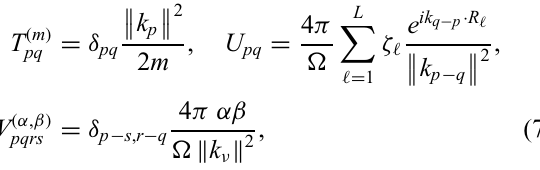
TABLE I. Best quantum algorithms for phase estimating chemistry in a plane-wave basis. N is number of basis functions, η < N is the number of electrons, (cid:10) is the computational cell volume, and (cid:9) is target precision. In some of these papers it is assumed that (cid:10) ∝ N or that (cid:10) ∝ η , but here we report the complexities without any such assumptions. Unlike other entries here, the scaling of the Kivlichan et al. [24] algorithm is empirically observed for specific systems (with some systems scaling somewhat better and some systems scaling somewhat worse) as opposed to rigorous upper bounds. The O ( N log N ) space complexity of Refs. [5,11,28] results from a Fourier-transform-based method of computing the potential operator discussed in Ref. [5]. If those papers were instead to use the Trotter steps introduced in Ref. [23] or Ref. [24], the algorithms would have N + O ( log N ) space complexity but gate complexity that is worse by approximately a factor of N . Algorithms with O ( N ) space complexity are likely impractical for any real problems in chemistry when using plane waves due to the large number of plane waves required to reach chemical accuracy; thus, O ( N log N ) space complexity is even less viable. We note that Appendix K introduces new algorithms defined in real space that match the scaling of those from Babbush et al. [42]. Primary innovation Logical qubits Toffoli/T complexity (cid:15) (cid:2) O Using plane waves with Trotter N + O ( log N ) [ η 2 N 17 / 6 1 + η(cid:10) 1 / 3 / N 1 / 3 /((cid:10) 5 / 6 (cid:9) 3 / 2 ) ] (cid:2) O Using plane waves with LCU N + O ( log N ) [ ( N 4 /(cid:10) 1 / 3 + N 11 / 3 /(cid:10) 2 / 3 )/(cid:9) ] (cid:2) O [ ( N 10 / 3 /(cid:10) 1 / 3 + N 8 / 3 /(cid:10) 2 / 3 )/(cid:9) ] Linear scaling quantum walks N + O ( log N ) (cid:2) O Low et al . [5] Using the interaction pic. O ( N log N ) [ N 8 / 3 /((cid:10) 2 / 3 (cid:9)) ] (cid:2) O [ (η 3 N 1 / 3 /(cid:10) 1 / 3 + η 2 N 2 / 3 /(cid:10) 2 / 3 )/(cid:9) ] First quantized qubitization O (η log N ) First quantized interaction pic. Better Trotter steps N + O ( log N ) Tighter Trotter bounds Yet tighter Trotter